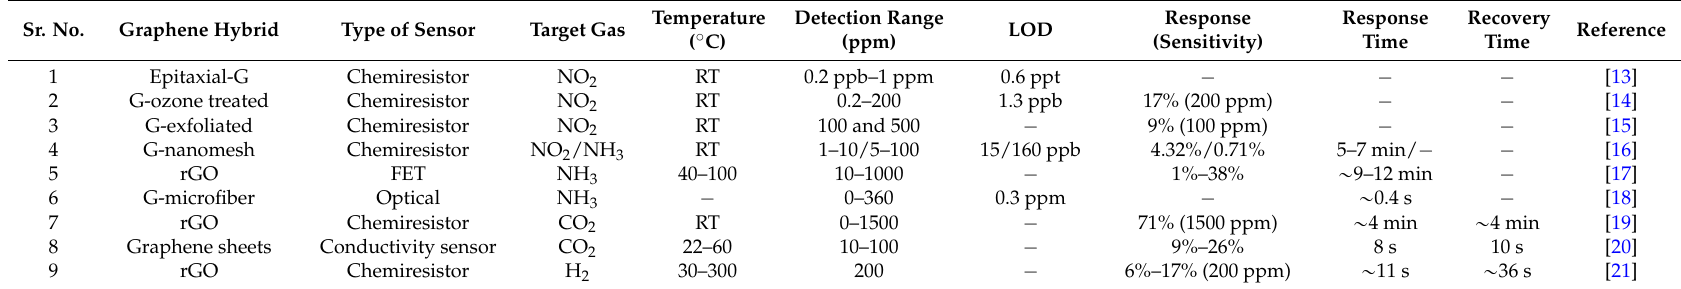
Table 1. Gas sensors based on graphene. G = Graphene; FET = field effect transistor; rGO = reduced graphene oxide; RT = room temperature; ppm = parts per million; ppt = parts per trillion.